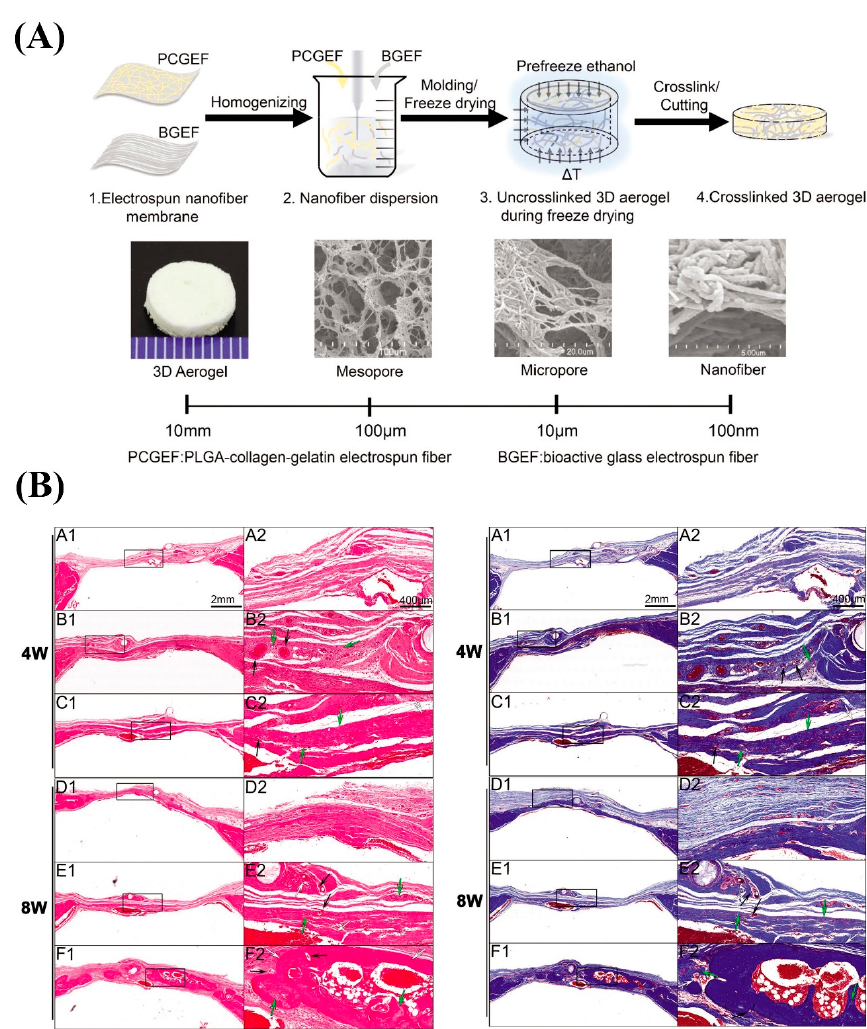
Figure 4. ( A ) Schematic representation of different steps of the preparation of the 3D hybrid nanofiber aerogels and its structure. ( B ) Images of hematoxylin and eosin-stained (left) and Masson’s trichrome- stained (right) tissue slides at 4 and 8 weeks post-implantation into critical-sized calvarial defects in rats. (A1/A2, D1/D2) Unfiled defects; (B1/B2, E1/E2) the defects implanted by 3D hybrid nanofiber aerogels (PCG/BG = 60:40); and (C1/C2, F1/F2) the defects implanted by E7-BMP-2 peptide-loaded 3D hybrid nanofiber aerogel (PCG/BG = 60:40) (black arrow: blood vessel in aerogel; white arrow: aerogel residue; green arrow: new bone) (adapted from Weng et al. [249] , with permission from John Wiley and Sons).